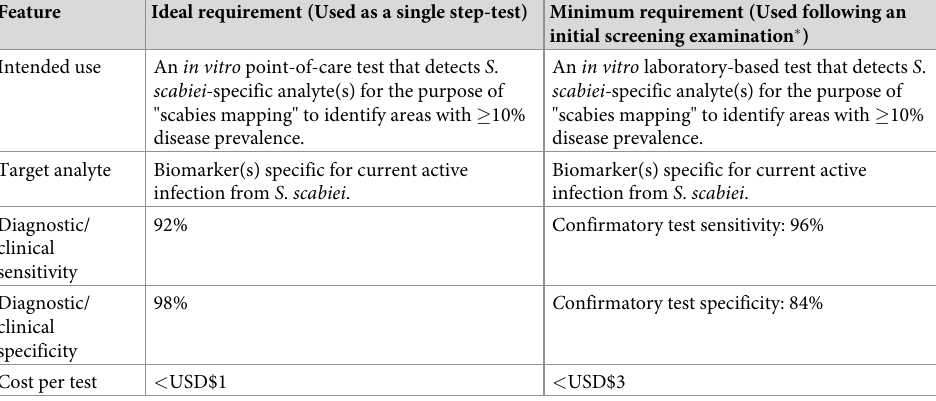
Table 2. Select characteristics of needed test for Starting